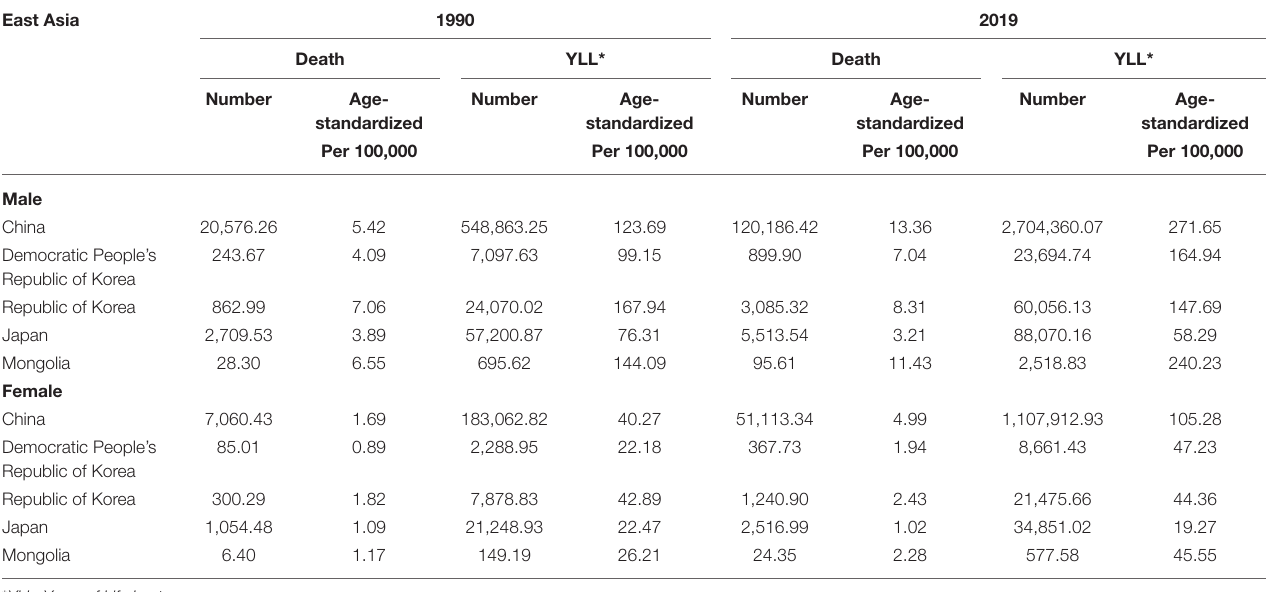
TABLE 1 | Lung cancer death and YLL attributable to PM 2.5 in East Asia in 1990 and 2019.